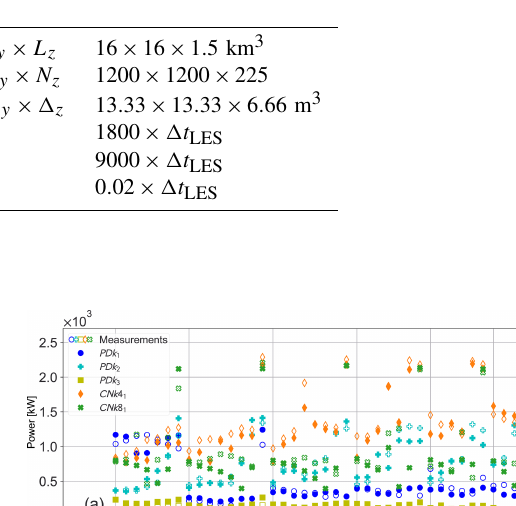
Table 4. Summary of the general domain parameters.